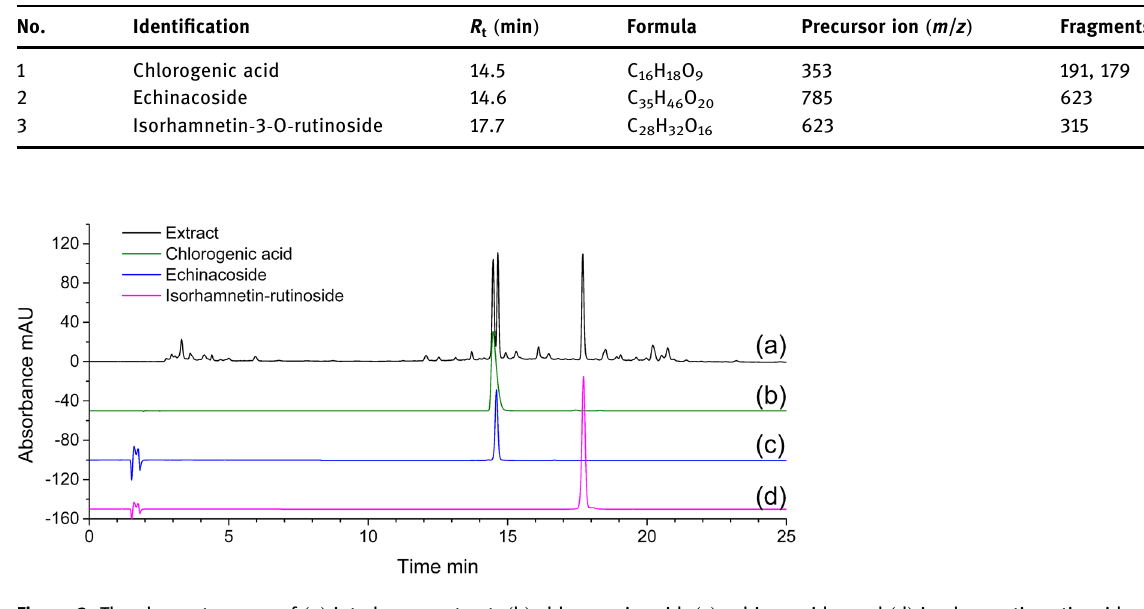
Figure 3: The chromatograms of ( a ) jute leaves extract, ( b ) chlorogenic acid, ( c ) echinacoside, and ( d ) isorhamnetin - rutinoside.